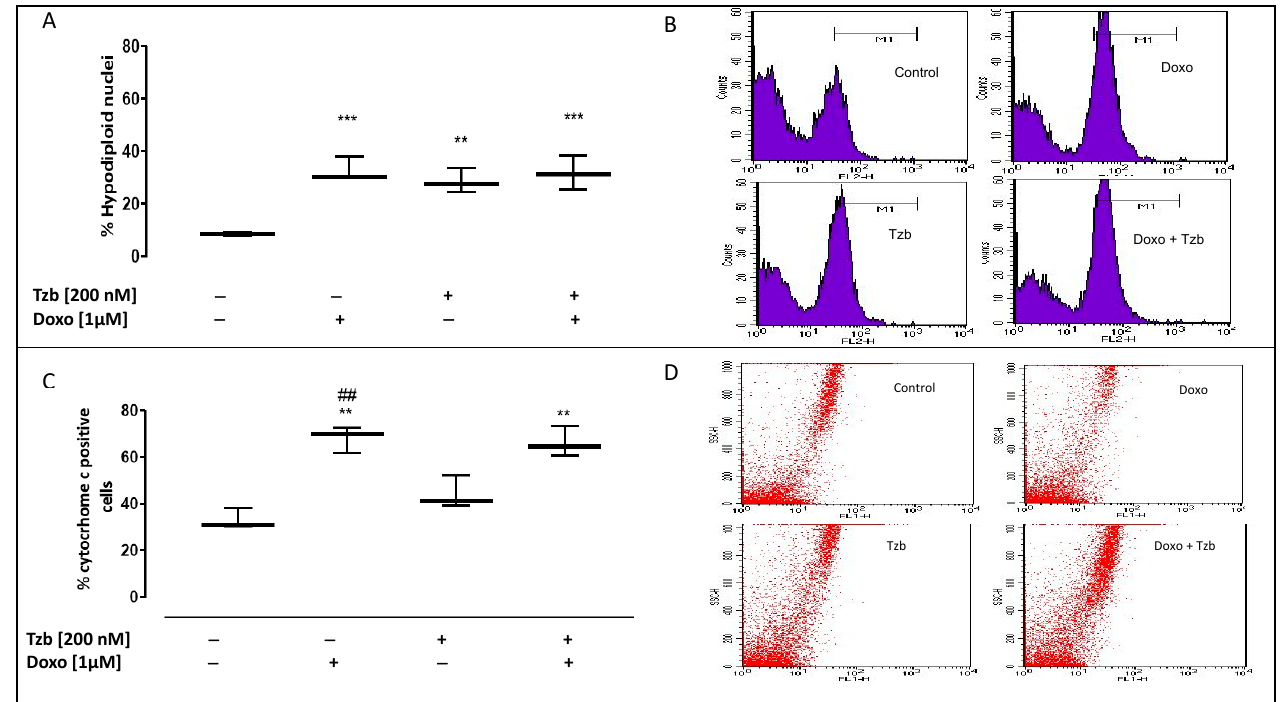
Figure 4. Doxo and Tzb and their association effect on apoptosis. Doxo (1 µ M) was administered for 4 h, and Tzb (200 nM) was administered for 20 h. H9c2 cells were stained by PI, and individual nuclei fluorescence was measured by flow cytometry. Results are expressed as mean ± S.E.M. of percentage of hyplodiploid nuclei from at least three independent experiments, each performed in duplicate (panel ( A )). Panels ( B ) reports the representative histograms for the flow cytometry analysis. Cytosolic cytochrome c level was detected by flow cytometry analysis. Results are expressed as mean ± S.E.M. of percentage of cytochrome c positive cells from at least three independent experiments each performed in duplicate (panel ( C )). Data were analysed by variance test analyses, and multiple comparisons were made by Bonferroni’s test. ** p < 0.005 and *** p < 0.001 vs. non-treated cells, ## p < 0.005 vs. Doxo-treated cells. Panel ( D ) reports the representative images of flow cytometry analysis of cytochrome c